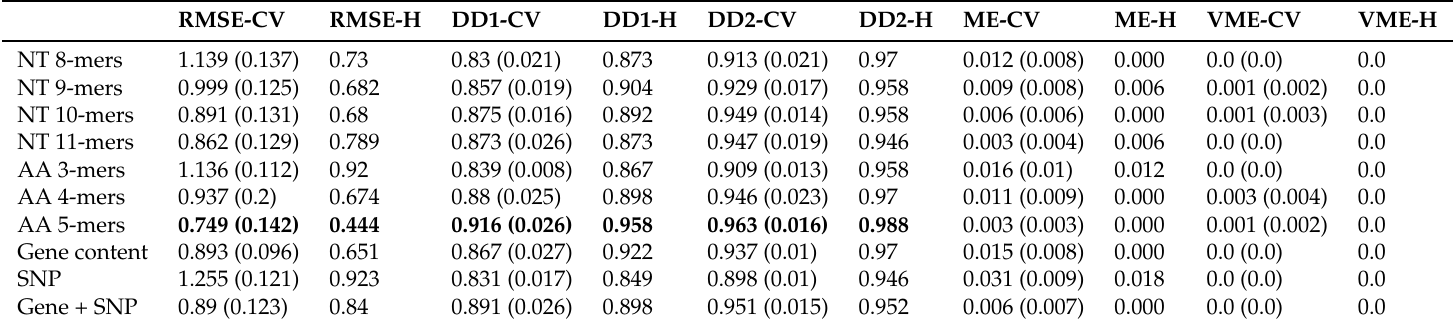
Table A43. K. pneumoniae –ceftriaxone.